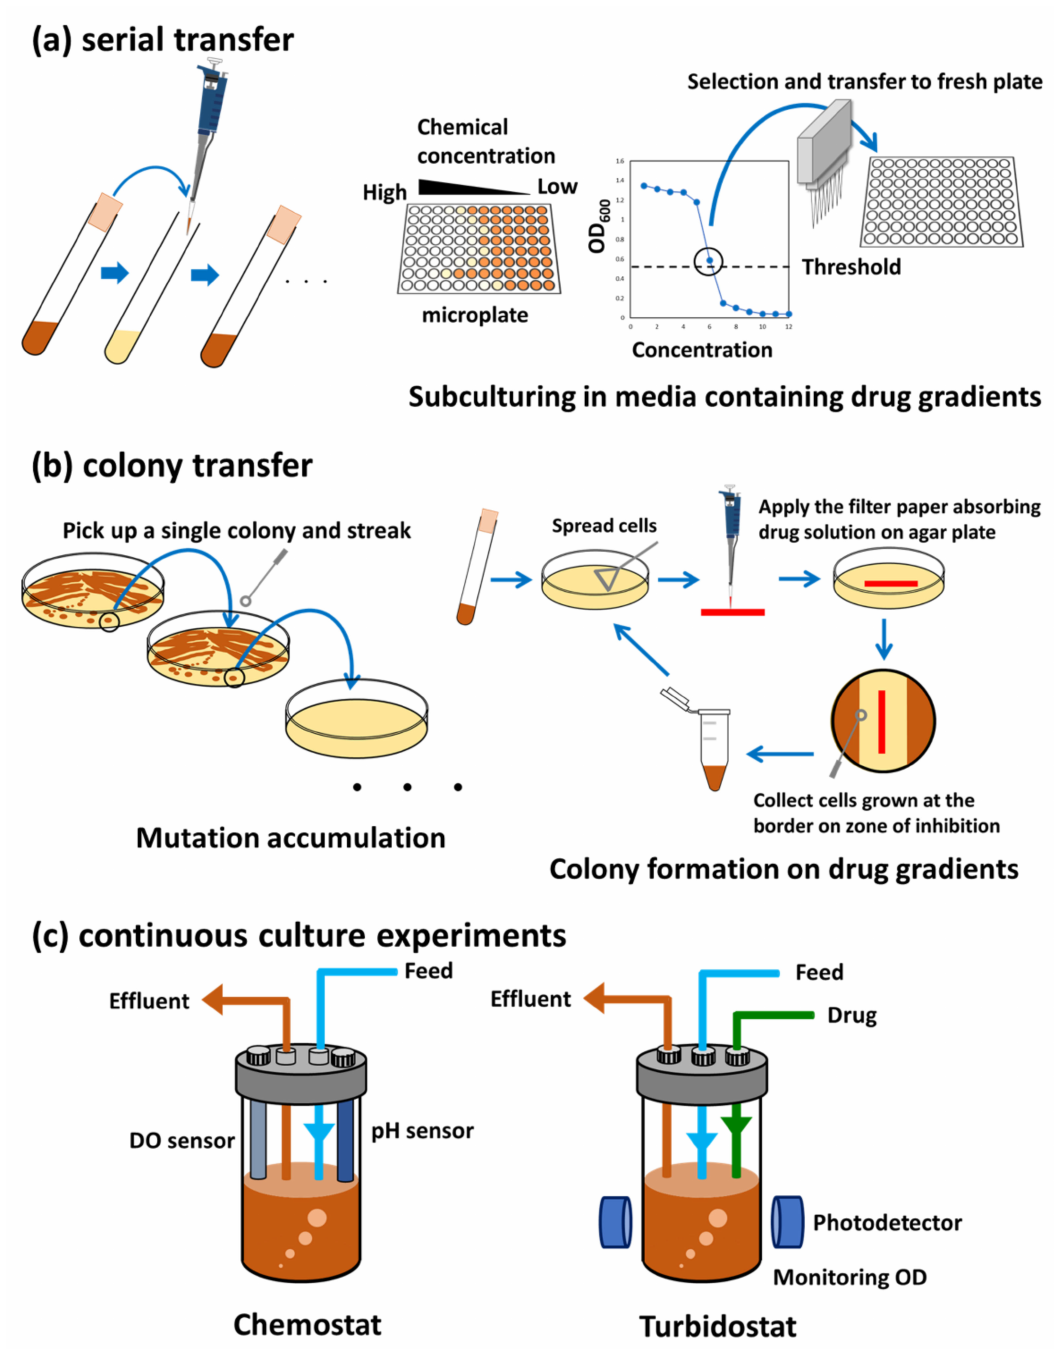
Figure 1. ALE methods. ( a ) Serial transfer. Serial transfer methods are based on repeats of subcultur- ing on fresh media at regular intervals. For ALE linked to stress resistance, subculturing on media containing drug gradients is often conducted to monitor stress resistance and maintain the selection pressure during ALE. ( b ) Colony transfer. Mutation accumulation (MA) is a method to analyze the mutation rate and molecular spectrum of spontaneous mutations. MA protocol repeatedly picks up a single colony on an agar plate and streaks it out on the next fresh agar plate. In order to select the highest resistant cells during ALE of stress resistance, drug gradients can be generated on an agar plate by applying a filter paper absorbing drug solution on the agar plate. ( c ) Continuous culture experiments. Chemostat culturing using a jar fermenter can precisely control constant growth rates, population densities, nutrient supply, and environmental conditions such as pH and oxygenation. Instead of maintaining the constant substrate concentration, a turbidostat has feedback between the turbidity of the culture and the dilution